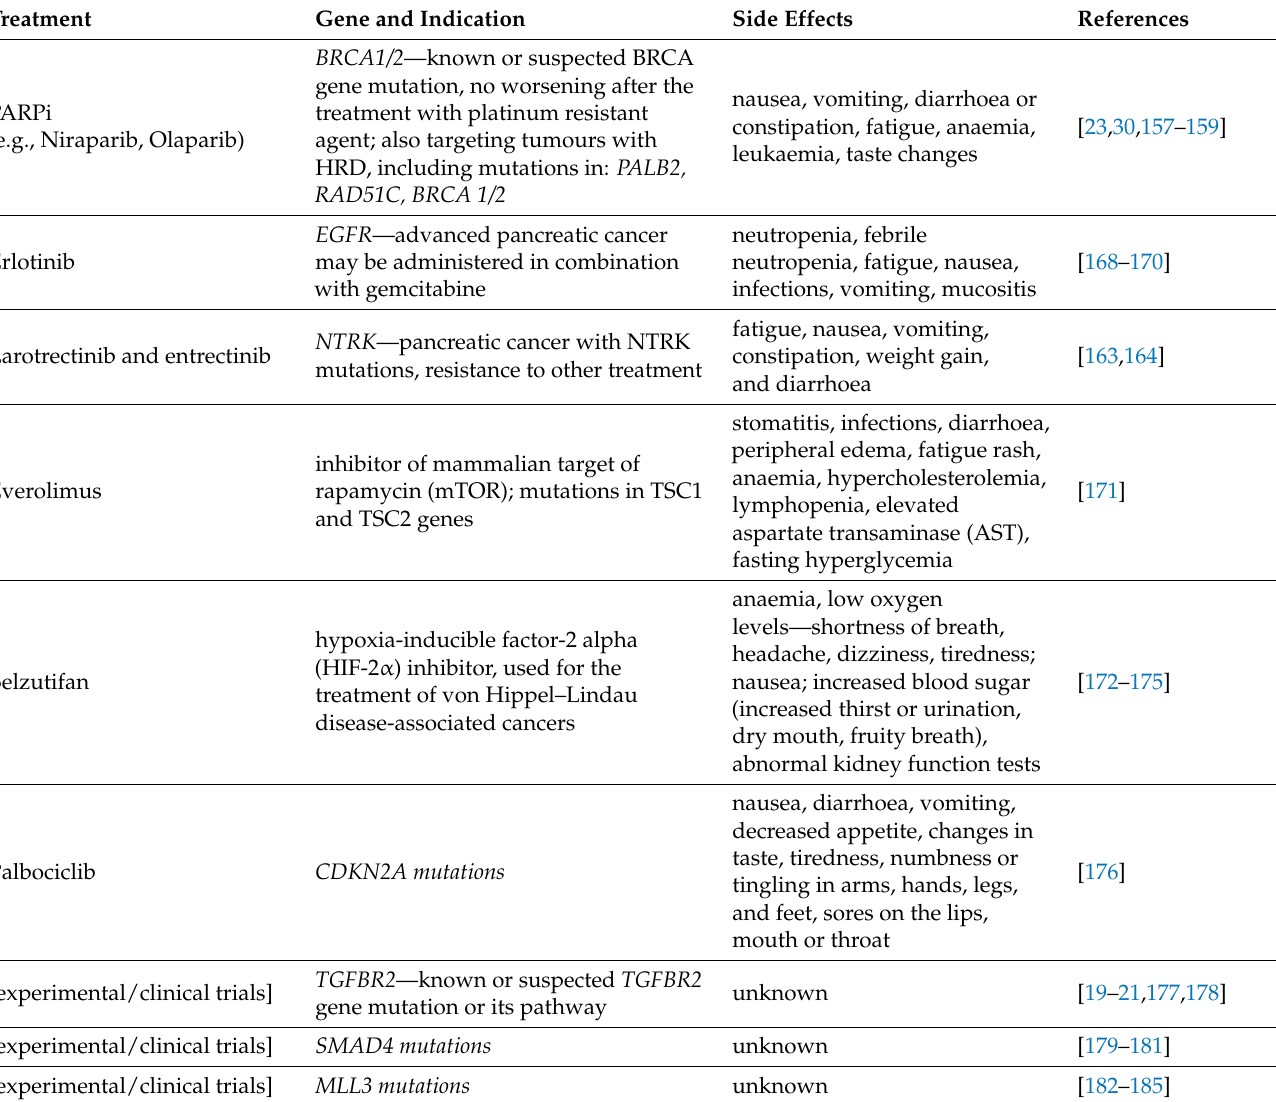
Table 3. Targeted therapies currently used and in clinical trials among pancreatic cancer